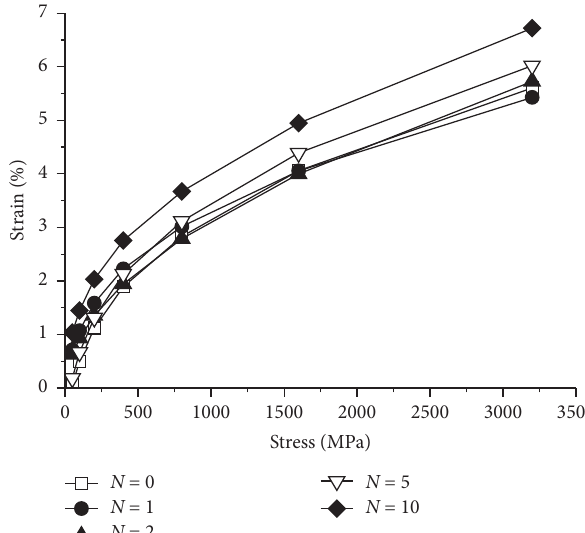
Figure 8: Stress-strain relationship curves of gravelly soil with a moisture content of 9.0% experiencing different numbers of freeze-thaw cycles at the cooling temperature of − 5 ° C and then being